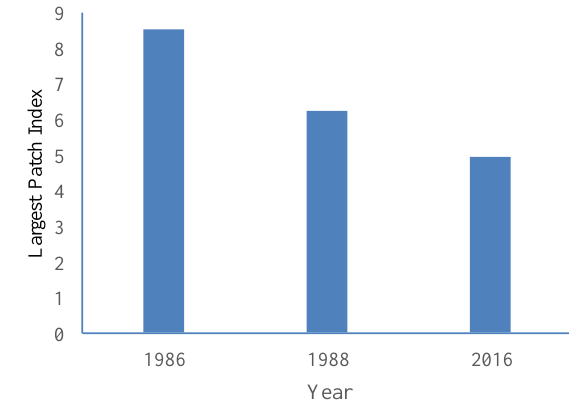
Figure 8. Changes in the Largest Patch Index (LPI) in 1986, 1998 and